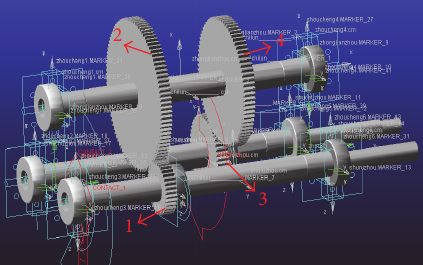
Figure 1: Dynamic model of gear transmission